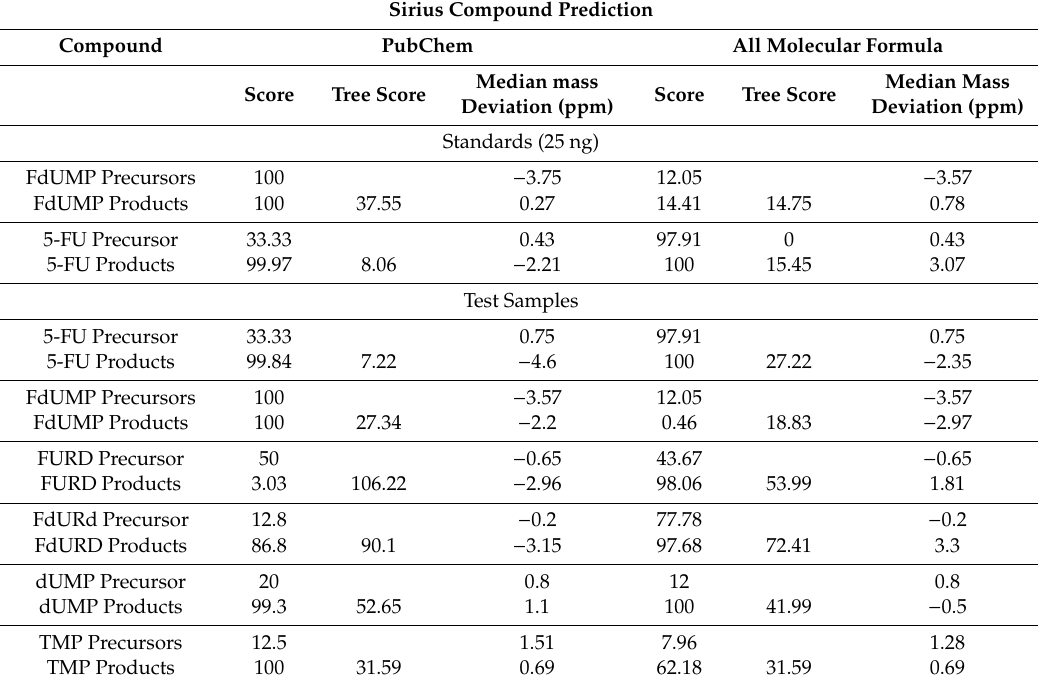
Table 4. SIRIUS scores validating the correct identification of the compounds. To validate that the compounds were identified correctly, MS1 and MS2 data exported from the skyline chromatograms were analyzed using the Sirius software. The data were compared with the PubChem database as well as with all the molecular formula options within the software and scores were obtained. Detection showed positive score for all detected compounds with the mass deviation within the acceptable range of -5 to 5 ppm. The tree score represents the positive fragment ions predicted for each